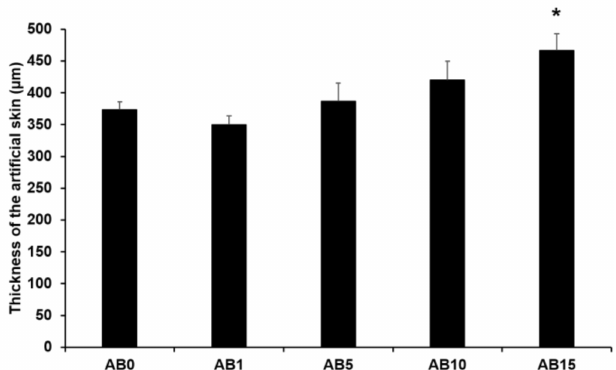
Figure 6. Thickness of the elastic artificial skin. Results are expressed as the means ± standard deviations of three independent experiments ( n = 3). AB0: Non-SLN artificial skin; AB1: Artificial skin with 1% SLNs; AB5: Artificial skin with 5% SLNs; AB10: Artificial skin with 10% SLNs; AB15: Artificial skin with 15% SLNs. Statistical significance of the difference in thickness between the elastic artificial skin without SLNs and the formulations with SLNs was indicated by a single asterisk ( p < 0.05). Table 6. Tensile strength, elongation at break, and Young’s modulus of the elastic artificial skins with/without adenosine-loaded solid lipid nanoparticles. Formulation Tensile Strength